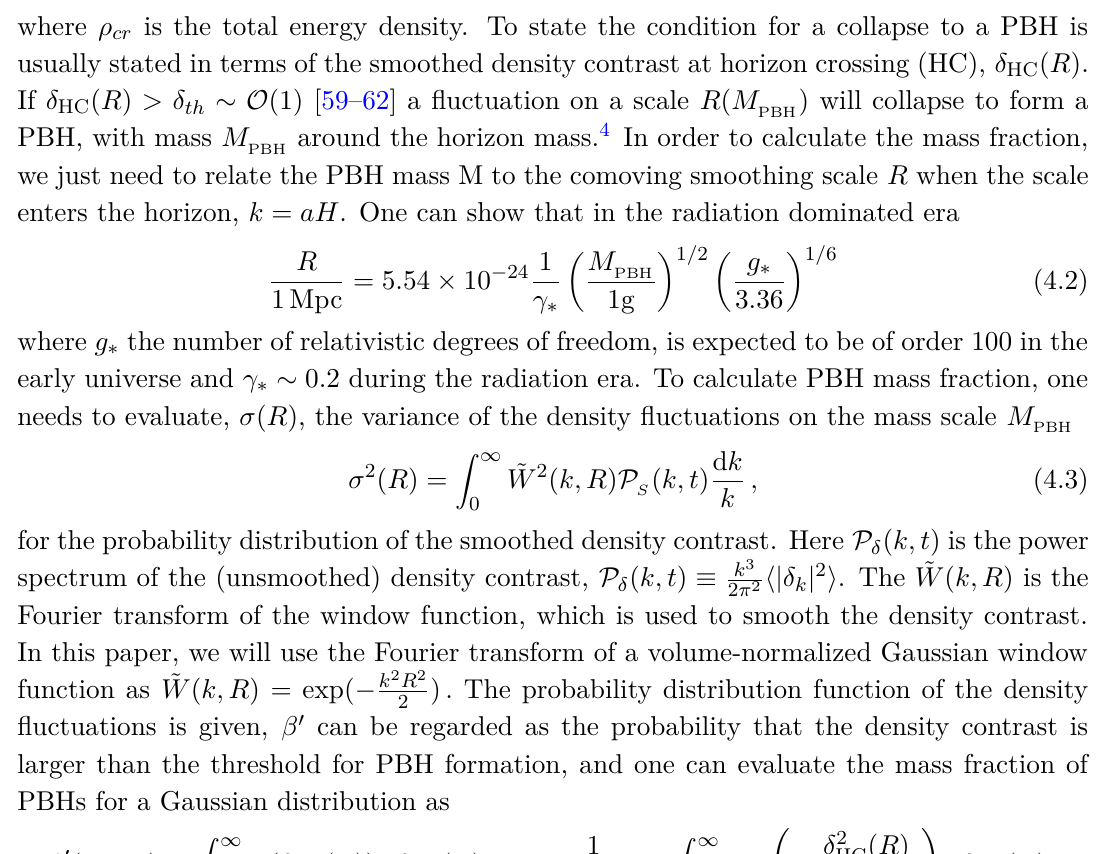
Figure 4 . This figure shows the fraction of PBH mass relative to dark matter in the present time coming up from γ in figure 2, in terms of its mass with the parameter δ th = 0 . 5